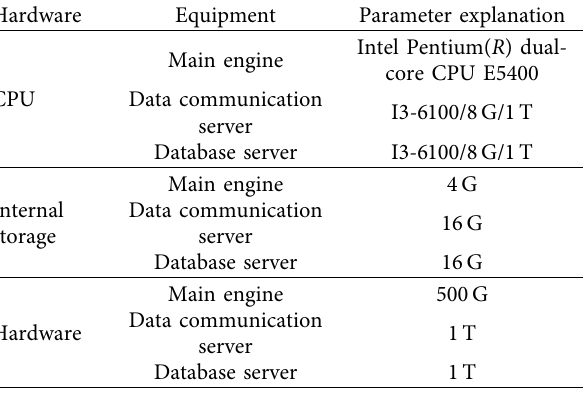
Table 2: Table of configuration parameters.